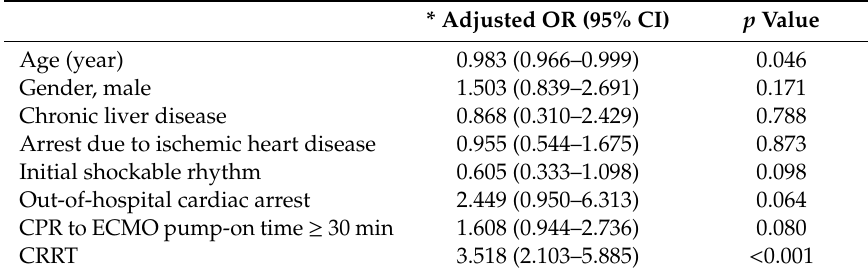
Figure 3. Kaplan-Meier curve for 30-day mortality between HH and non-HH groups. HH, hypoxic hepatitis. Table 2. Factors associated with occurrence of hypoxic hepatitis.